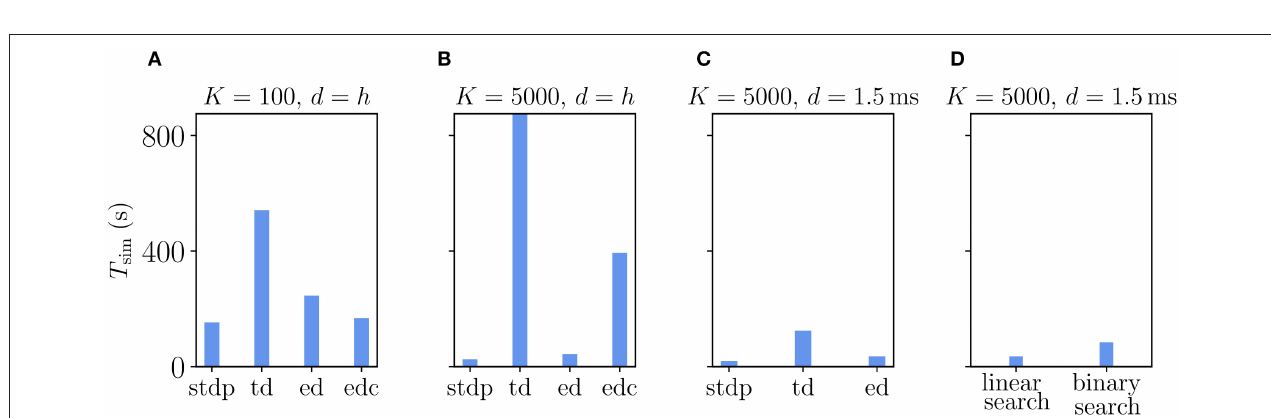
FIGURE 9 | Comparison of simulation times T sim for excitatory-inhibitory networks with different implementations of the Clopath plasticity in NEST. Simulation times exclude network building and only account for updates of the dynamical state of the system. The following implementations are shown: “stdp”: standard implementation of STDP synapse, “td”: time-driven implementation of Clopath synapse, “ed”: event-driven scheme as included in NEST 2.20.1, “edc”: event-driven compression. (A) Network of size N = 1.92 · 10 6 with small in-degree K = 100 and all synapses having a delay d equal to the resolution of the simulation h = 0.1ms. (B) Network of size N = 1.54 · 10 5 with large in-degree K = 5,000 and d = h . (C) Same network as in (B) but d = 1.5ms (for d > h “edc” not compatible with NEST, see section 3.1.3). In (A–C) both “ed” and “edc” use linear search of the history and access counters, see Appendix Section 5.3 . (D) Comparison between “ed”-implementations using linear search and direct computation of the position, see Appendix Section 5.3.0.2 . All simulations use 768 threads distributed over 32 compute nodes each running one MPI process. Further parameters as in Supplementary Table 5